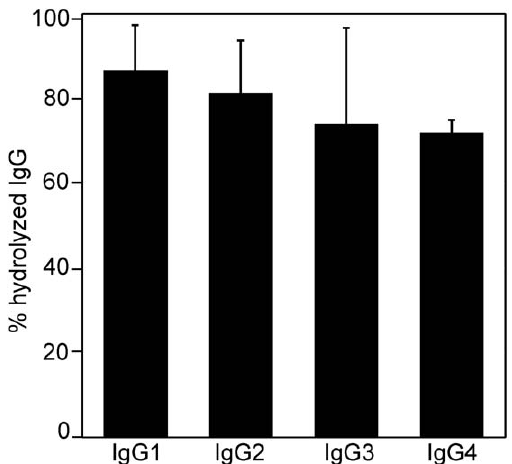
Figure 2. Hydrolysis of human IgG-subclasses by EndoS in plasma environment . Human plasma treated with EndoS or PBS and followed by IgG glycan hydrolysis detection using LCA lectin ELISA of the purified IgG fraction. The results are presented as percent hydrolysis of each subclass compared to signals from untreated plasma. Means and standard deviations, indicated with error bars, were calculated from three independed experiments using blood from three different donors.